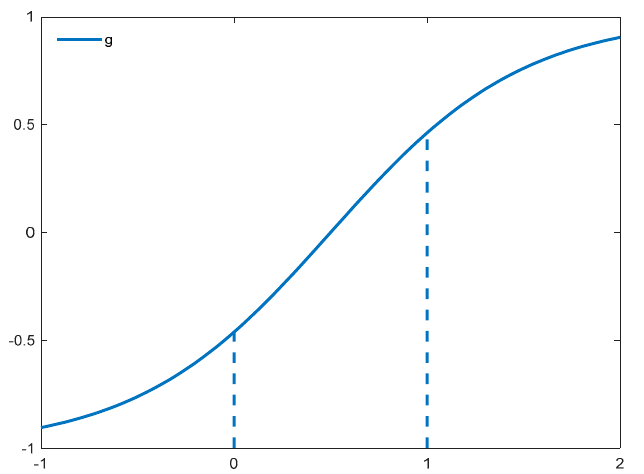
Figure 3. The governing function for generating the random step g (where x axis represents a randomly generated value between 0 and 1, while y axis signifies the search step g , as defined in Equation (26)):